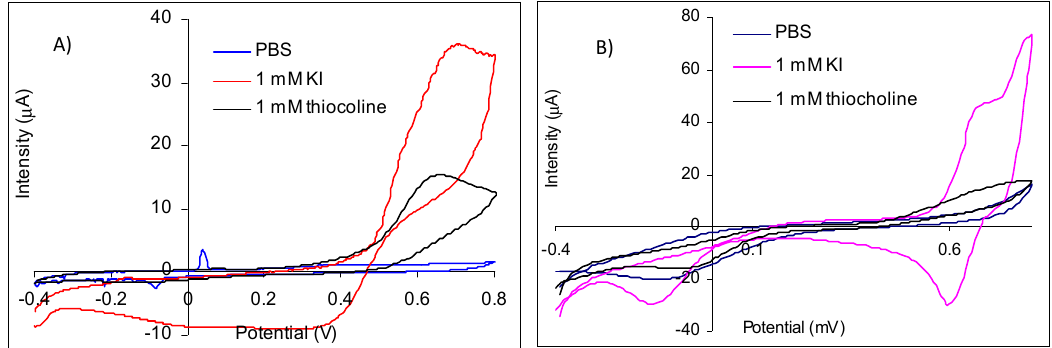
Figure 2. The cyclic voltammograms obtained in PBS, iodide and thiocholine solutions using: ( A ) gold screen-printed electrode. ( B ) platinum screen-printed